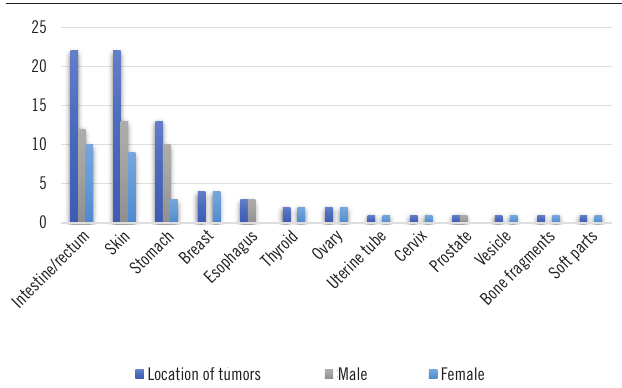
Location of tumors Male FigurE − Distribution of the anatomical location of malignant tumors and gender comparison